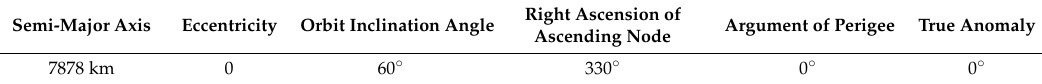
Table 1. Satellite orbit parameters.